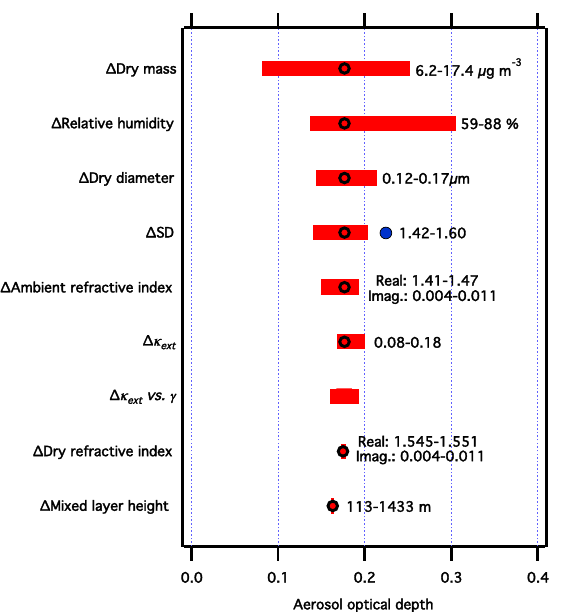
Figure 4. Range in AOD at a wavelength of 532nm due to vari- ations in measured parameters. AOD values integrated from pro- files using a model aerosol size distribution and the 10th and 90th percentile range of observed aerosol and meteorological parame- ters (bars) and from the median profile (black circles). Numerical values show the extinction-weighted 10th–90th percentile range of the indicated parameter. The “ κ ext vs. γ ” bar describes the change in AOD associated with choice of hygroscopicity model, centered on the median AOD. The “ (cid:49) Mixed layer height” numerical val- ues show the range in the simulated height of the well-mixed layer. The blue symbol on the “ (cid:49) SD” line shows calculated AOD using a fixed geometric standard deviation of 1.8 as prescribed in the Modal Aerosol Model used in the CAM-Chem earth system model (Liu et al.,